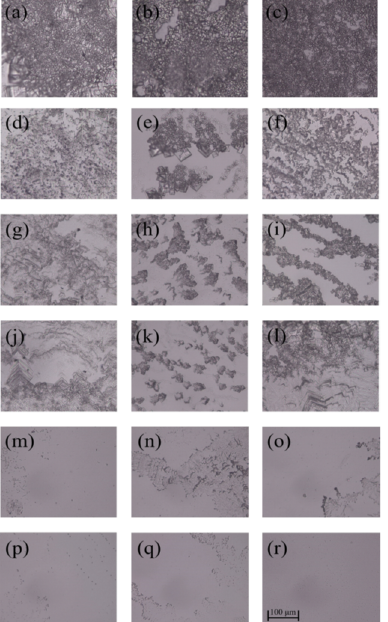
Figure 6. The inhibitory effect of AG-GT-2 on E. coli biofilms: ( a – c ) are the E. coli biofilms developed for 1, 3 and 5 days in control group, ( d – f ) are the E. coli biofilms treated with AG-GT-2 at a concentration of 1/4 MIC for 1, 3 and 5 days, ( g – i ) are the E. coli biofilms treated with AG-GT-2 at a concentration of 1/2 MIC for 1, 3 and 5 days, ( j – l ) are the E. coli biofilms treated with AG-GT-2 at a concentration of MIC for 1, 3 and 5 days, ( m – o ) show the E. coli biofilms treated with AG-GT-2 at a concentration of 2 MIC for 1, 3 and 5 days, ( p – r ) present the E. coli biofilms treated with AG-GT-2 at a concentration of 4 MIC for 1, 3 and 5 days, respectively.